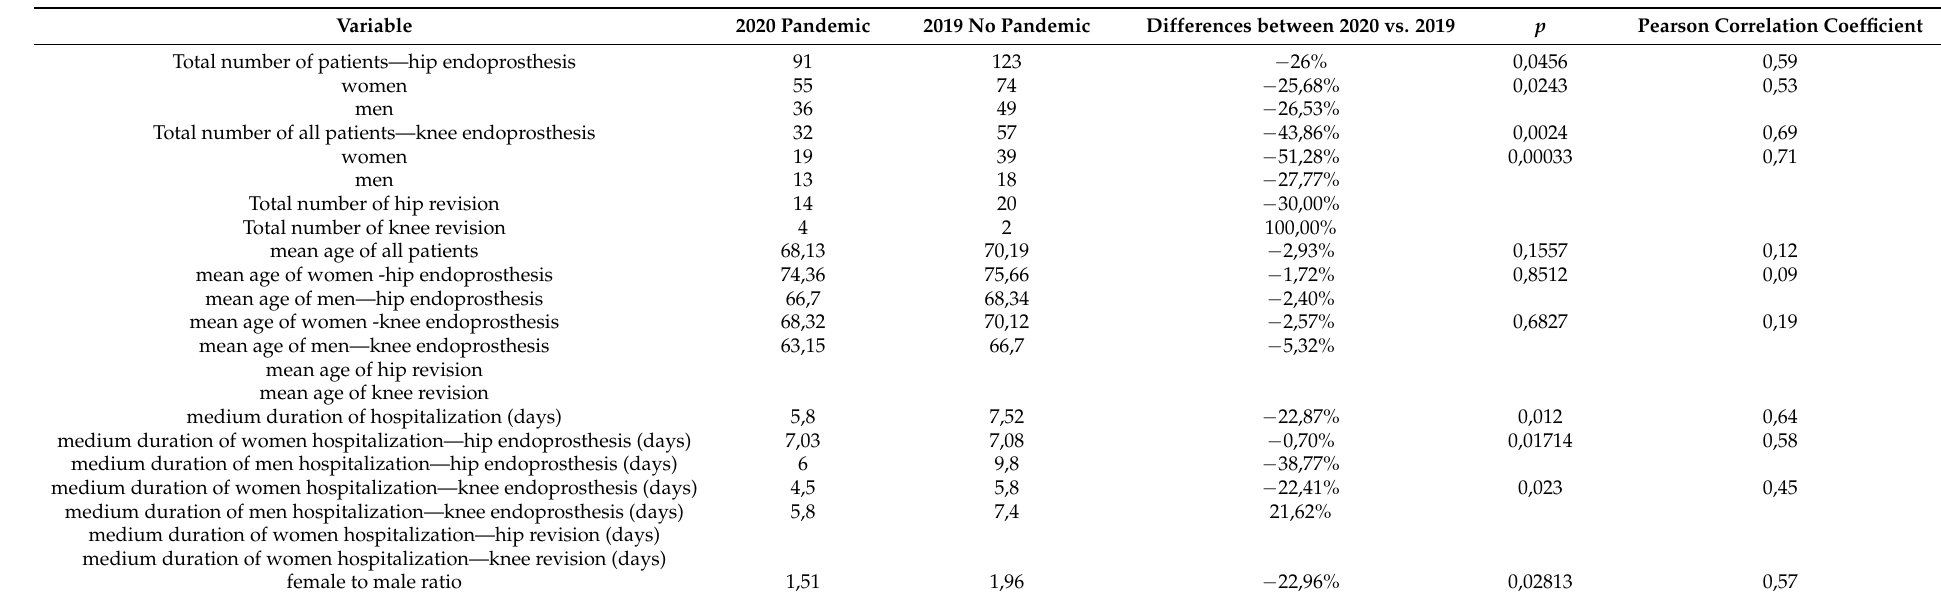
Table 1. Epidemiological characteristics of patients who underwent hip and knee